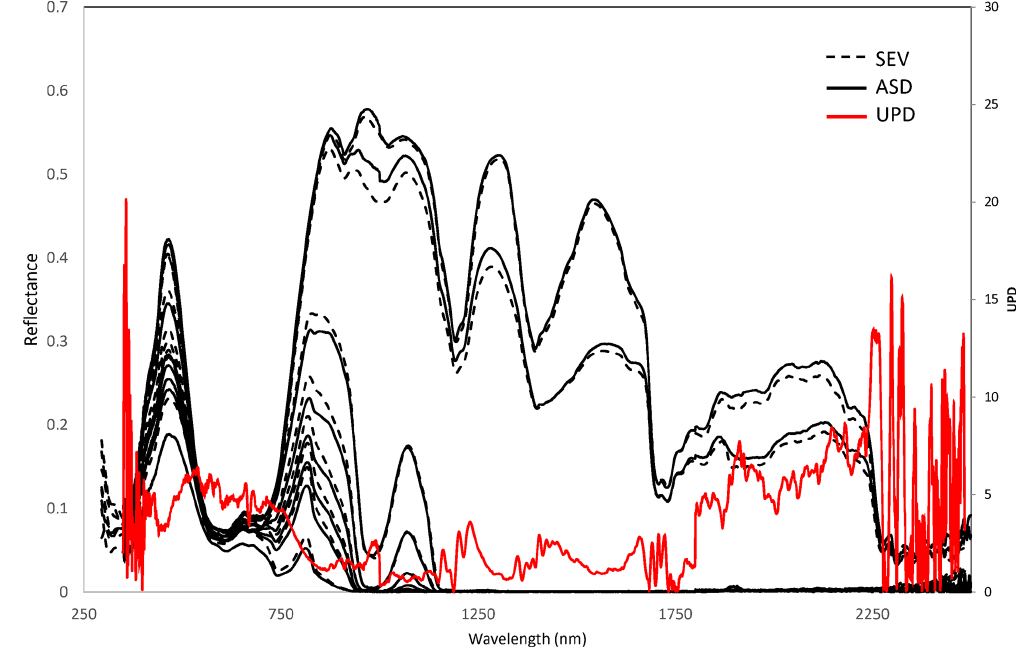
Figure 13. Comparison of ASD and SEV with unbiased percentage difference (UPD) for the orange place mat.